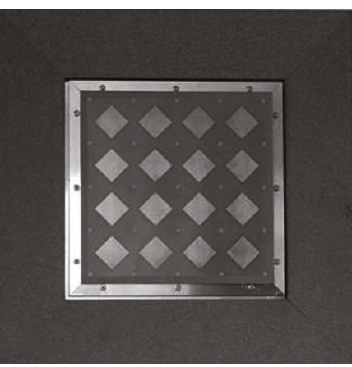
Figure 4: Receiving antenna array.